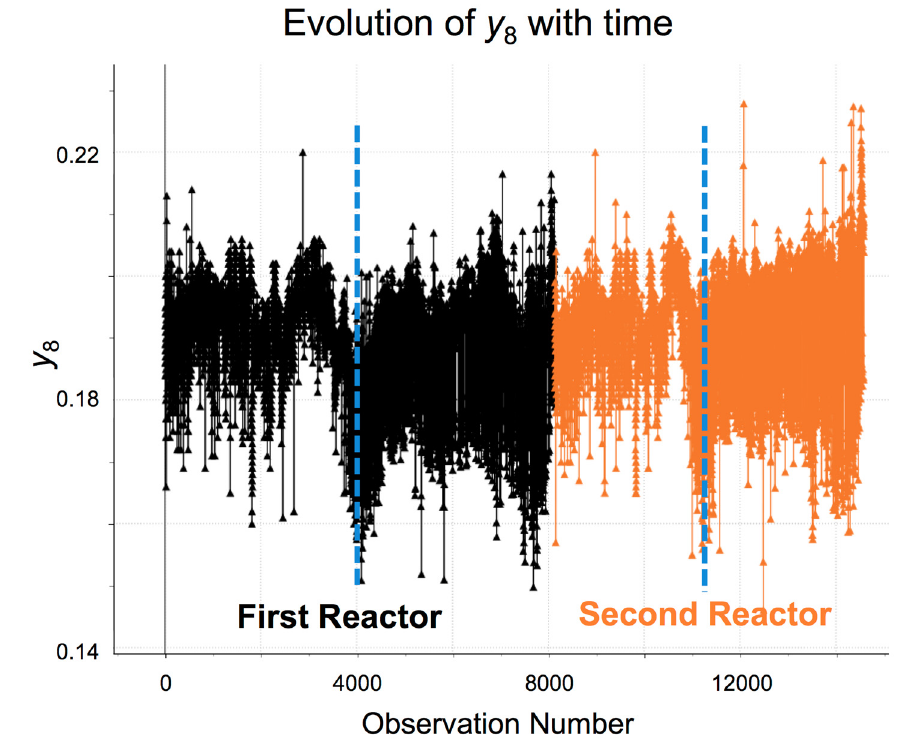
Figure 6. Evolution of the purity of the product of interest ( y 8 ) with time for the first (black) and second (orange) reactors; the dashed blue lines separate batches produced before (left side) and after (right side) September 2014.